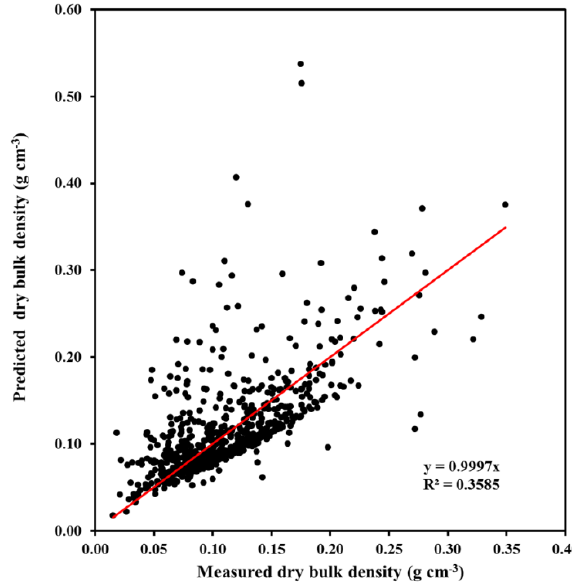
Figure 5. Regression of predicted dry bulk density on measured dry bulk density for a set of Indonesian peats (intact peat swamp forest, logged forest and oil palm